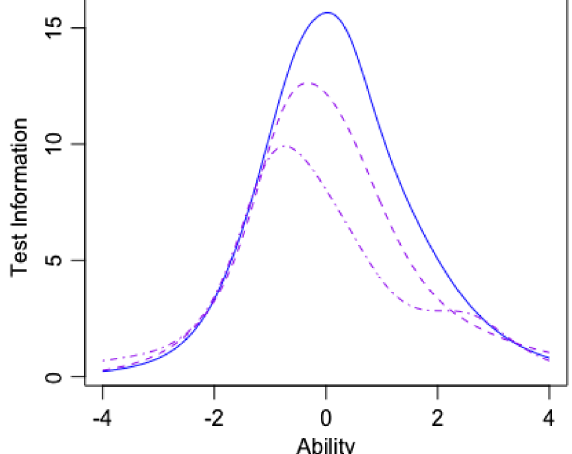
FIG. 8. Item response theory test information curves for the CSEM (blue, solid), BEMA (purple, dashed), and BEMA(R) (purple,